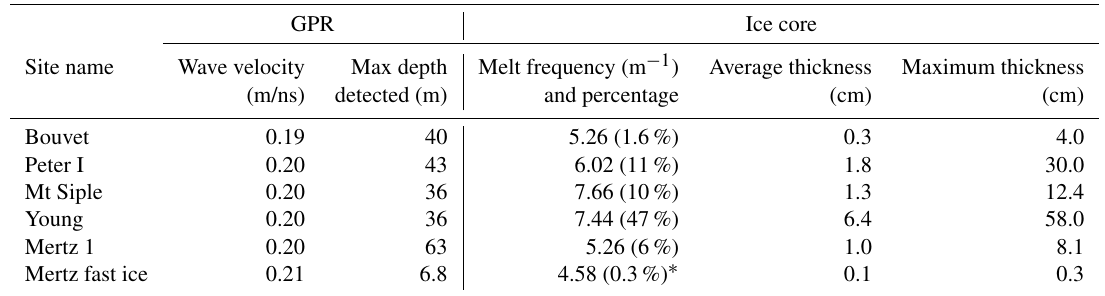
Table 2. Wave velocity and maximum depth detected from the GPR. Frequency (number of layers per metre), percentage (of whole core), average, and maximum layer thickness measured in the ice cores.